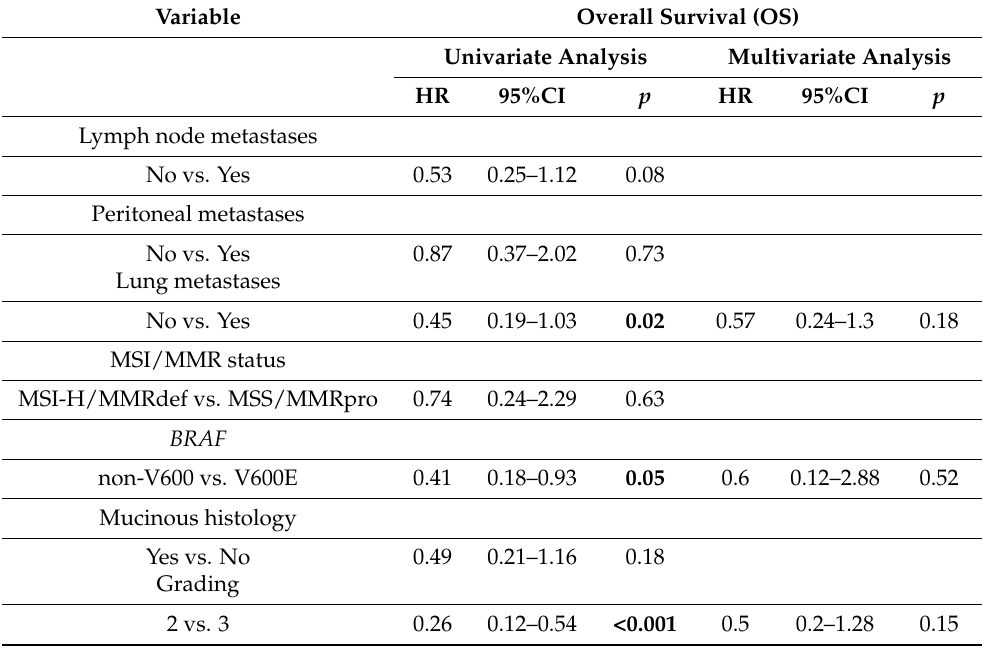
Table 3. Cont. Variable Overall Survival (OS) Univariate Analysis Multivariate